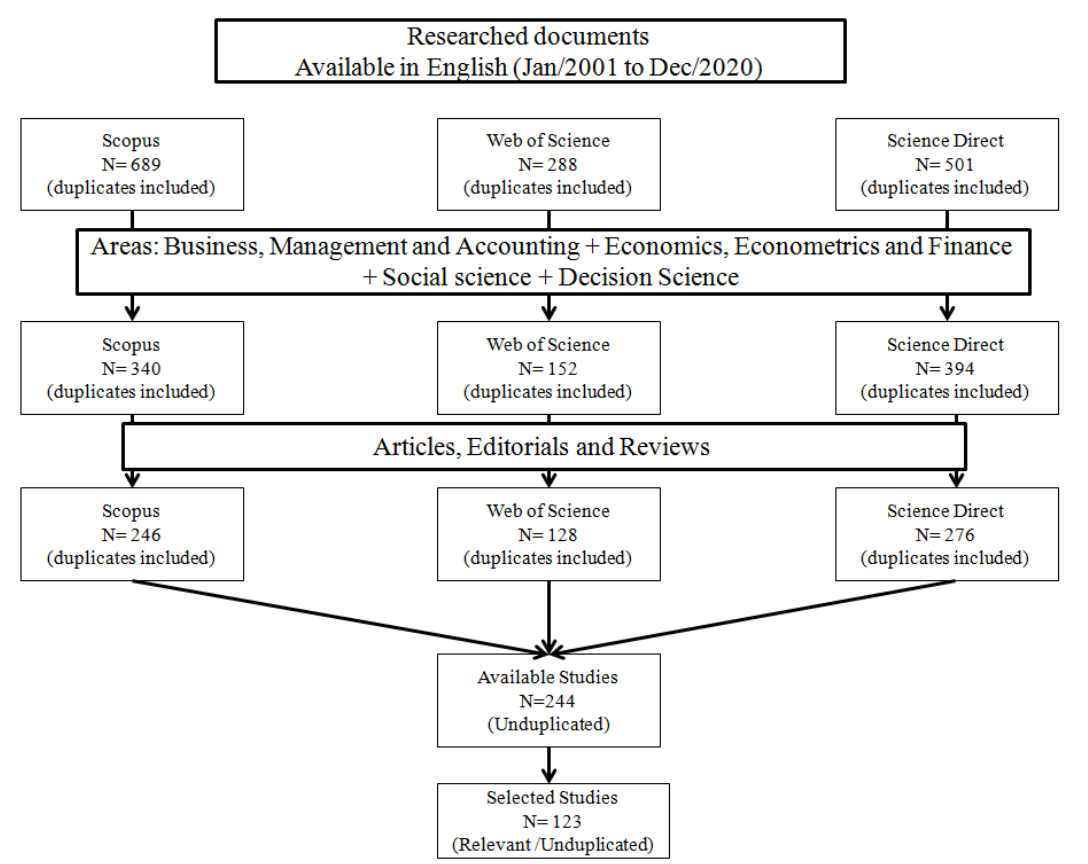
Figure 2. Selection criteria for the analyzed documents. Source: the authors.